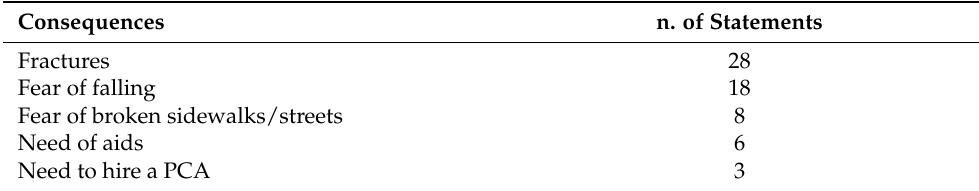
Table 4. Consequences of